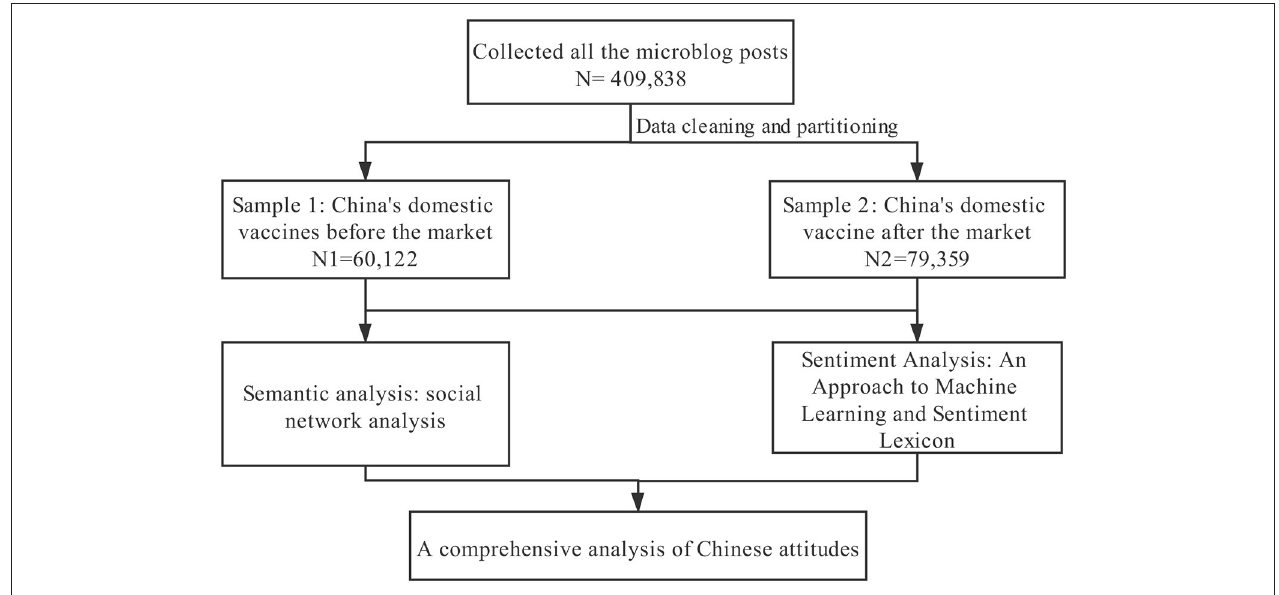
FIGURE 1 | Design of this